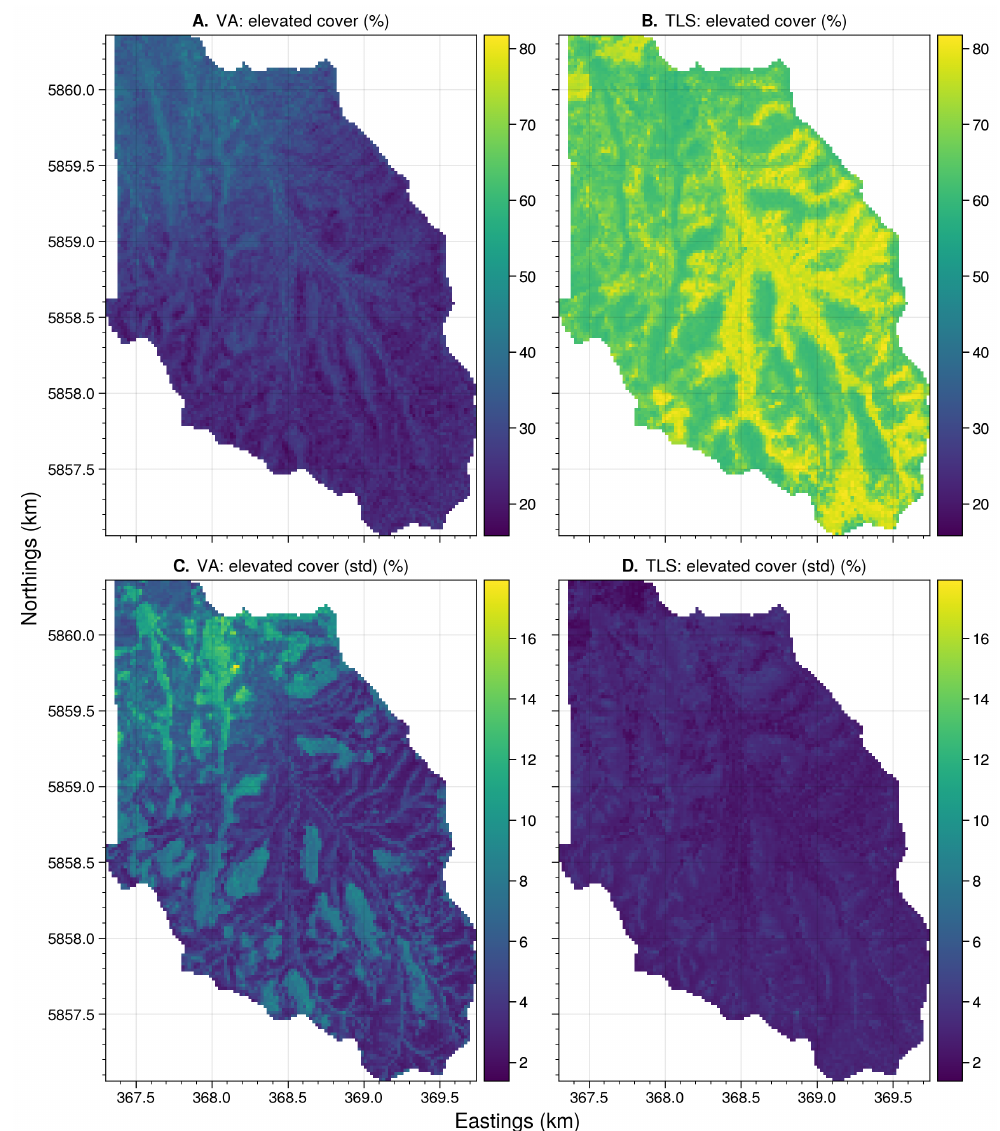
Figure A11. The mean and standard deviation of landscape-level predictions for elevated fuel cover using visual assessments ( A , C ) and TLS ( B , D ) at